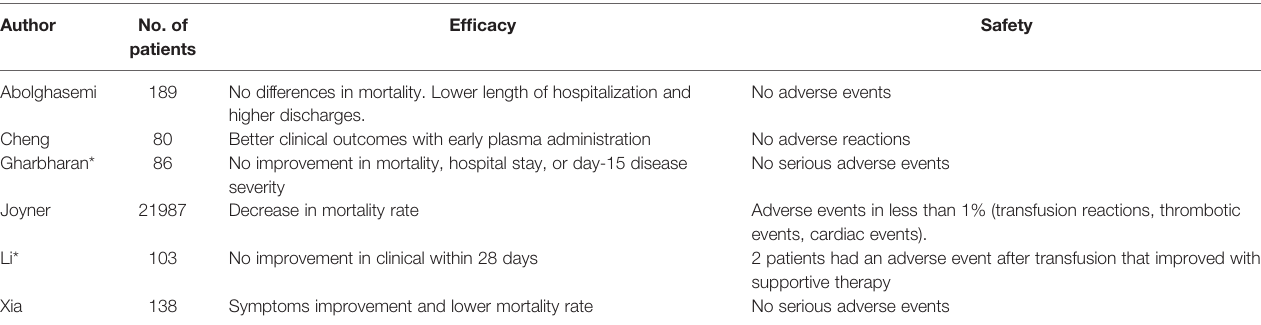
TABLE 1 | Ef fi cacy and safety of convalescent plasma transfusion as a treatment for COVID-19